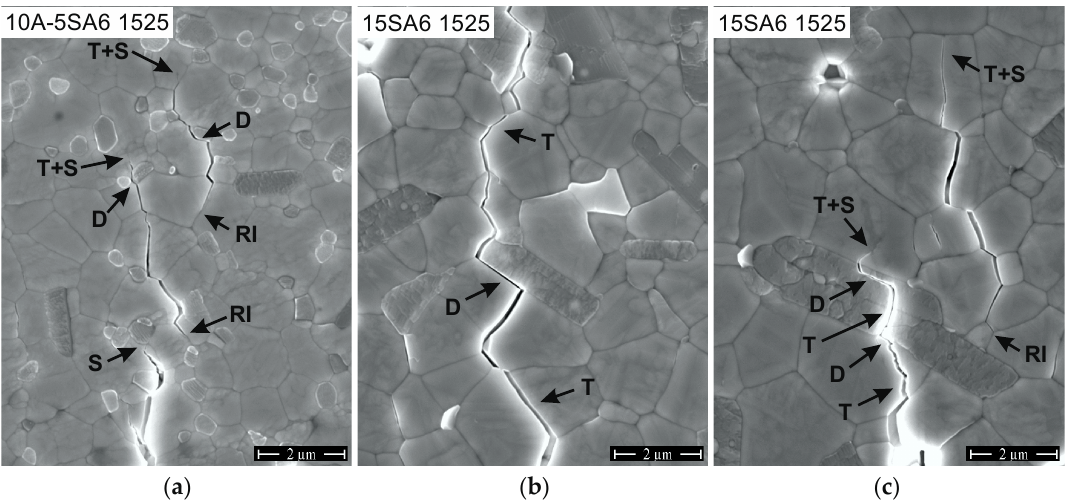
Figure 2. SEM images of crack propagation in different composites for: ( a ) 10A-5SA6-1525, ( b ) 15SA6-1525, ( c ) 15SA6-1525 (crack direction always from bottom to top).